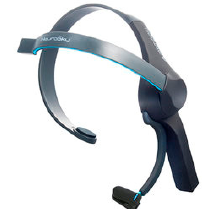
Figure 1. MindWave Mobile, NeuroSky.